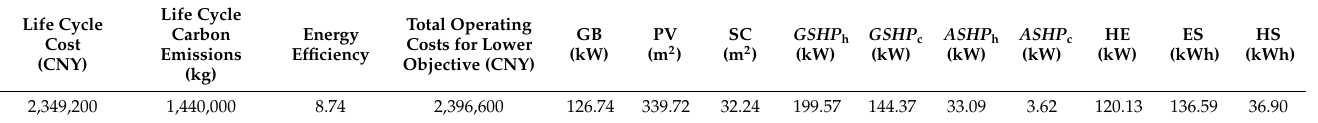
Table 4. Optimal compromise solution of bi-level multi-objective optimization of the MCS.